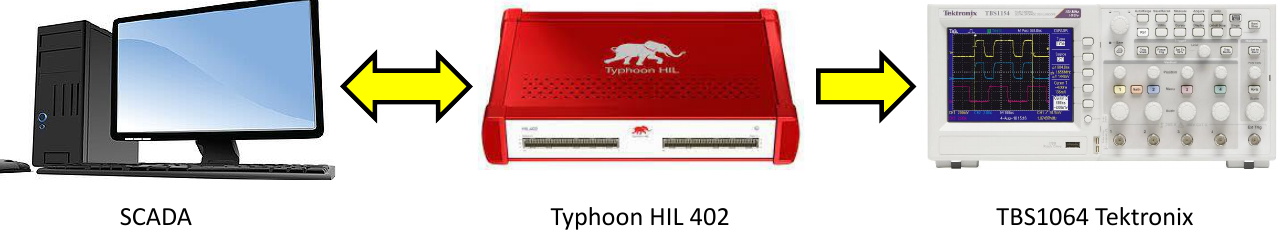
Figure 19. An overview of the real-time simulation platform for acquiring experimental